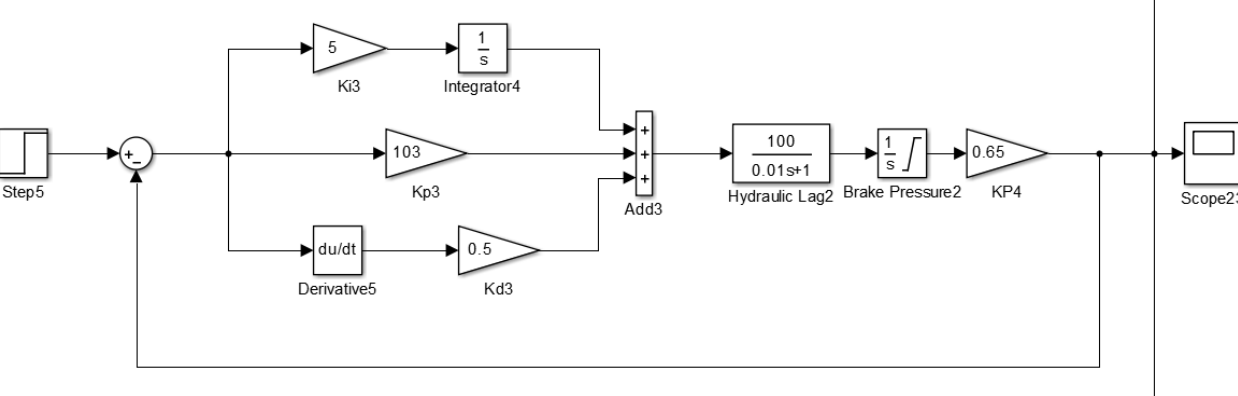
Figure 11. Unit step response curve of the braking system. 3.2. Lower Actuators 3.2.1. Judgment Logic for the Braking Target Wheel Cylinder When a vehicle is in danger of overturning, a transverse swing moment opposite to the direction of overturning should be loaded onto it. As shown in Figure 12, when brak- ing, only the angular velocity of the transverse swing generated by the front outer and inner wheels of the car is opposite to the direction of the turn, and the stabilizing trans- verse swing moment generated by the front outer wheel is the most e ff ective.